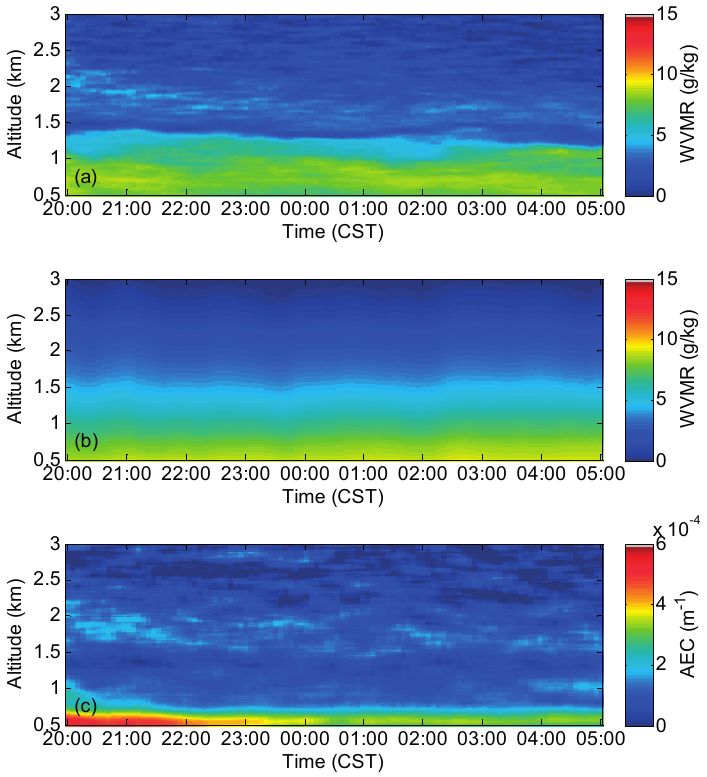
Figure 4. Observation time was from 8:00 p.m., 10 September 2013 to 05:00 11 September 2013 CST. ( a , b ) show the temporal variation in the 30-min WVMRs measured by the data of the RL and MR, respectively; ( c ) Temporal variation in the 30-min AEC retrieved by N 2 -Raman signals of the RL, and the measured time was same as (a).